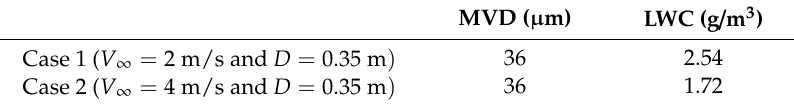
Table 1. Water droplet characteristics generated by the spray bottle.